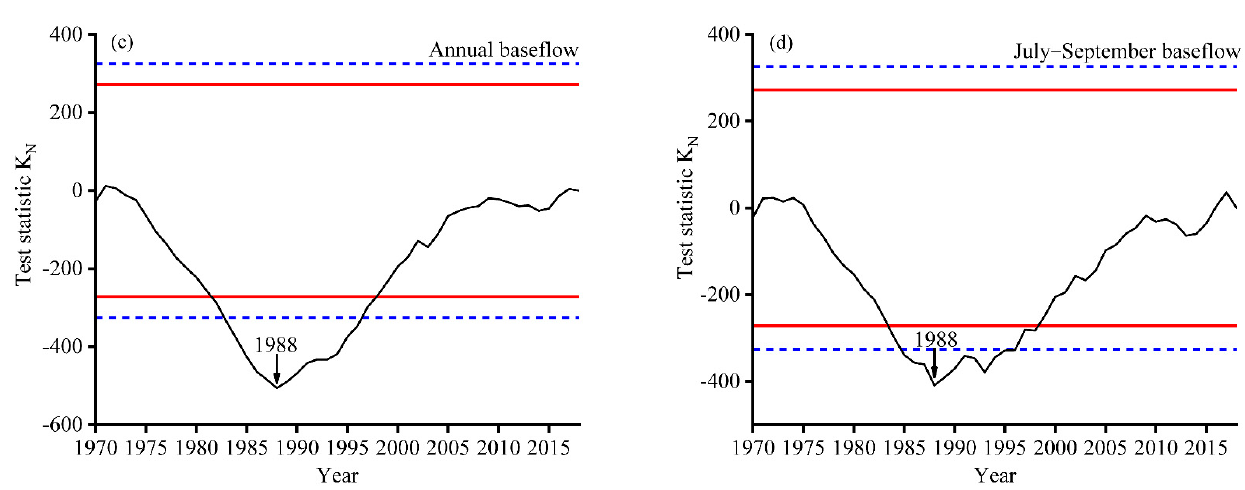
Figure 2. Abrupt points identified by Pettitt’s test KN statistic in ( a ) annual streamflow, ( b ) July–September streamflow, ( c ) annual baseflow and ( d ) July–September baseflow in the Beiluo River Basin. Horizontal lines in every graphic indicate the significance levels of 1% (dotted) and 5% (solid). When a minimum or maximum value of KN statistic exceeds out of the two lines, it means the timing of a statistically significant abrupt point.